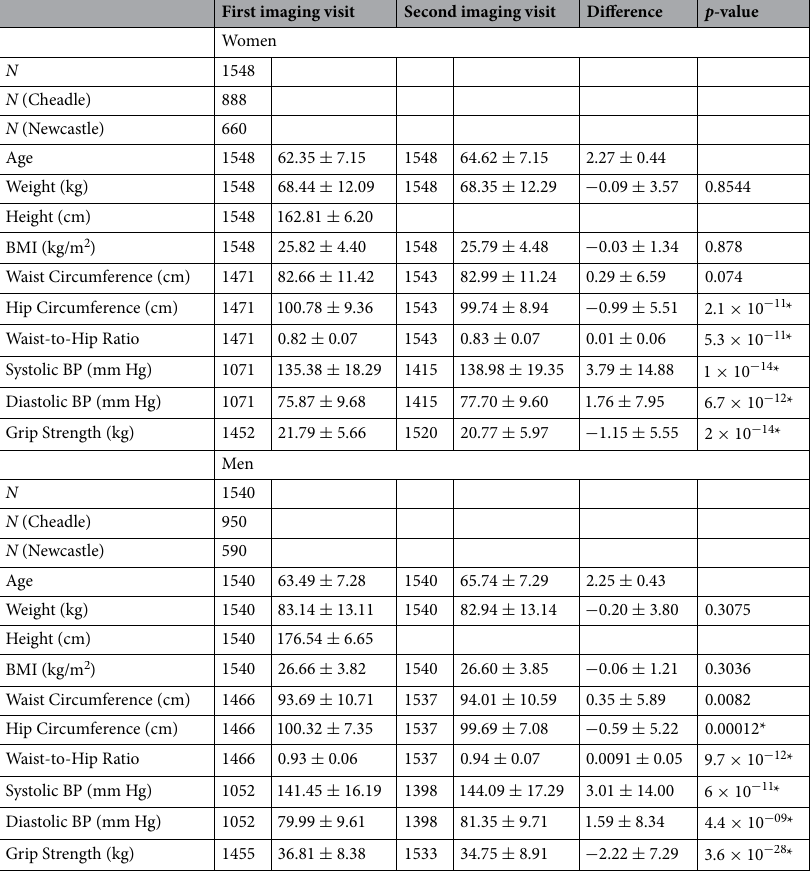
Table 3. Demographics for participants in the longitudinal cohort, separated by gender. Values are reported as mean and standard deviation. An asterisk (*) indicates the p -value is below the significance threshold adjusted for multiple comparisons. BMI: body mass index; BP: blood